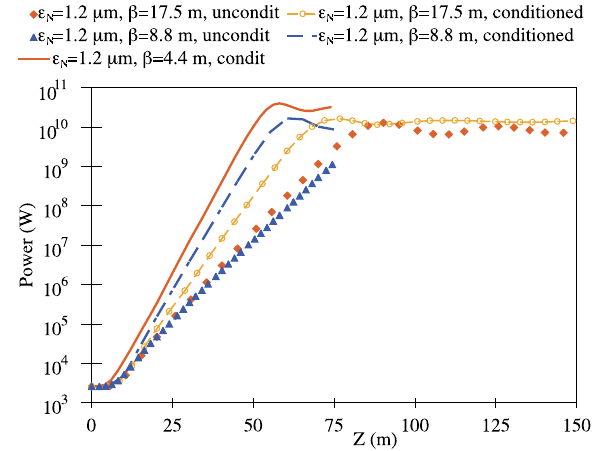
FIG. 3. (Color) Radiation power as a function of undulator length for LCLS, with different beta functions, and with conditioned and unconditioned beams.